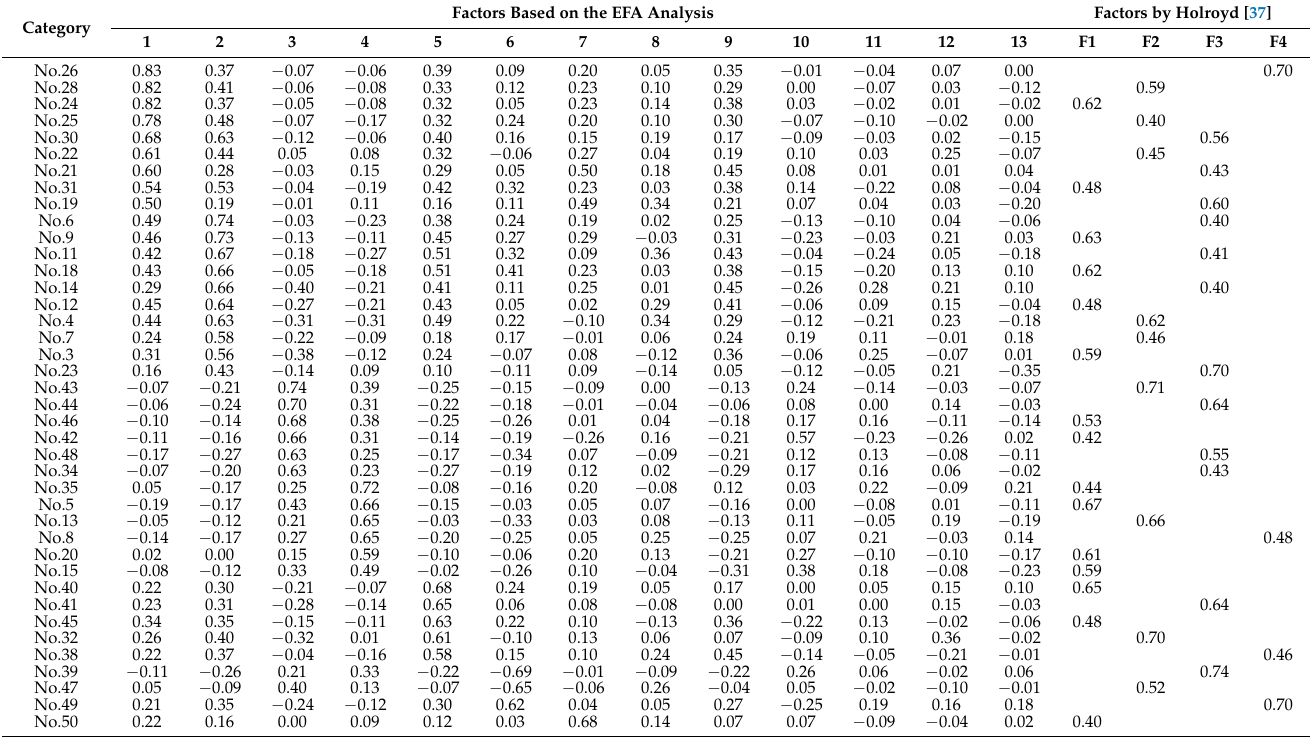
Table 3. The rotated factor matrix based on 13 factors and 4 factors by Holroyd. Factors Based on the EFA